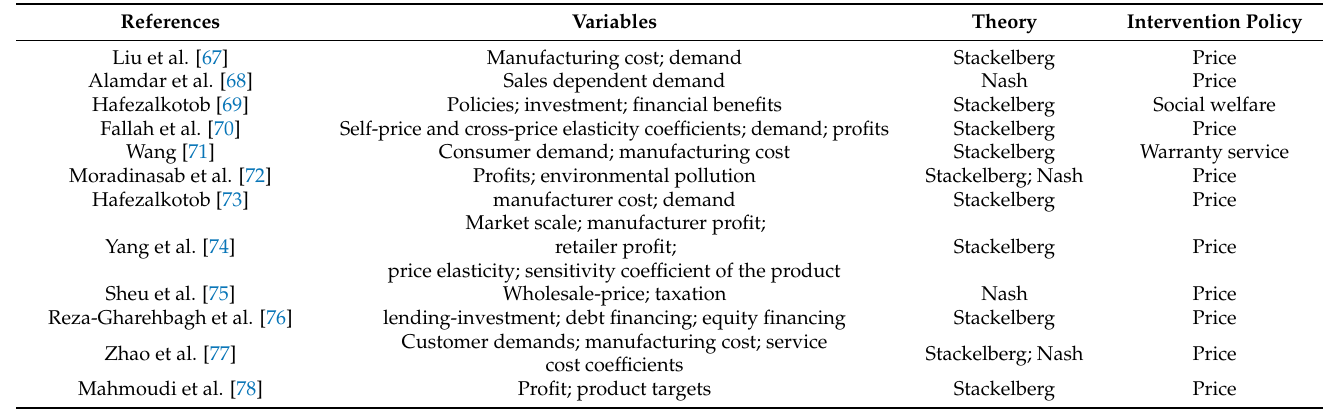
Table 1. Summary of previous studies.